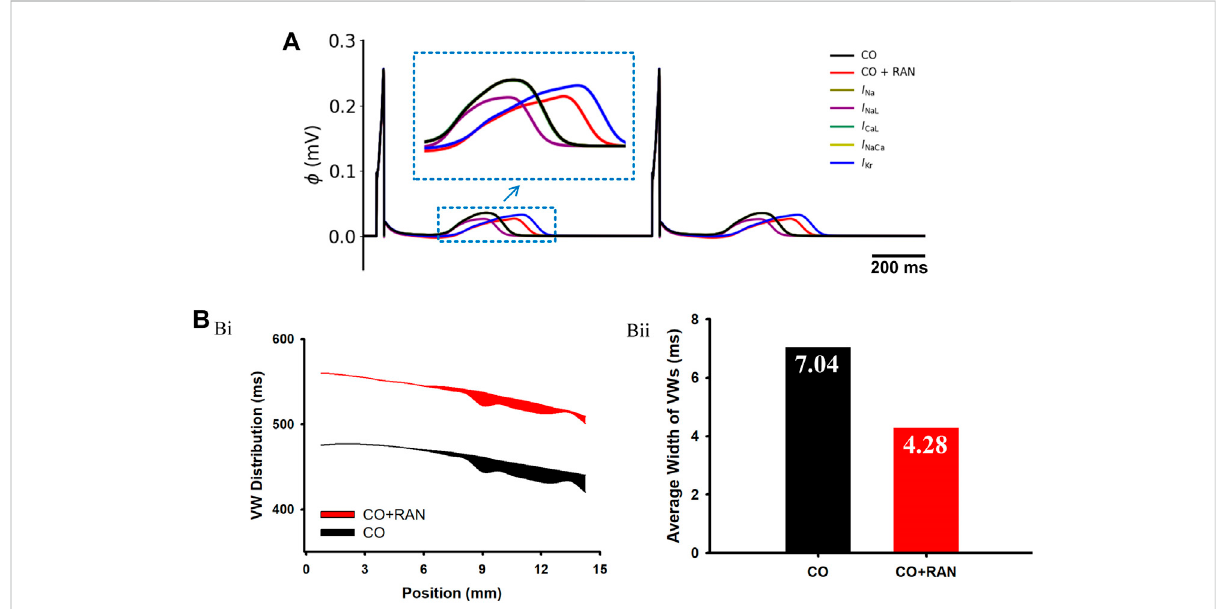
FIGURE 6 Simulation results of ranolazine single-channel analysis and Vulnerable Window (VW) in a 1D transmural ventricular strand model. (A) Pseudo- ECG under the single-channel effect of ranolazine. (B) Simulation results for VW. (Bi) Distribution of VWs across the strand. Black and red belts stand for the ‘ CO ’ and ‘ CO + ranolazine ’ conditions, respectively. (Bii) Comparisons of the average width of VWs in the two